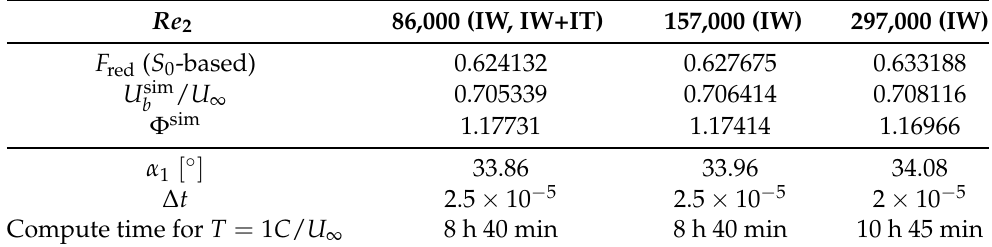
Table 1. LPT bar passing setup with cylinder parameters in the upper portion of the table. Re 2 = 86,000 was simulated both with inflow wakes (IW) and inflow turbulence (IT), while other regimes analyse IW alone. The compute time is estimated on 1000 cores on the Archer supercomputer, including runtime post-processing and thus providing a conservative estimate.